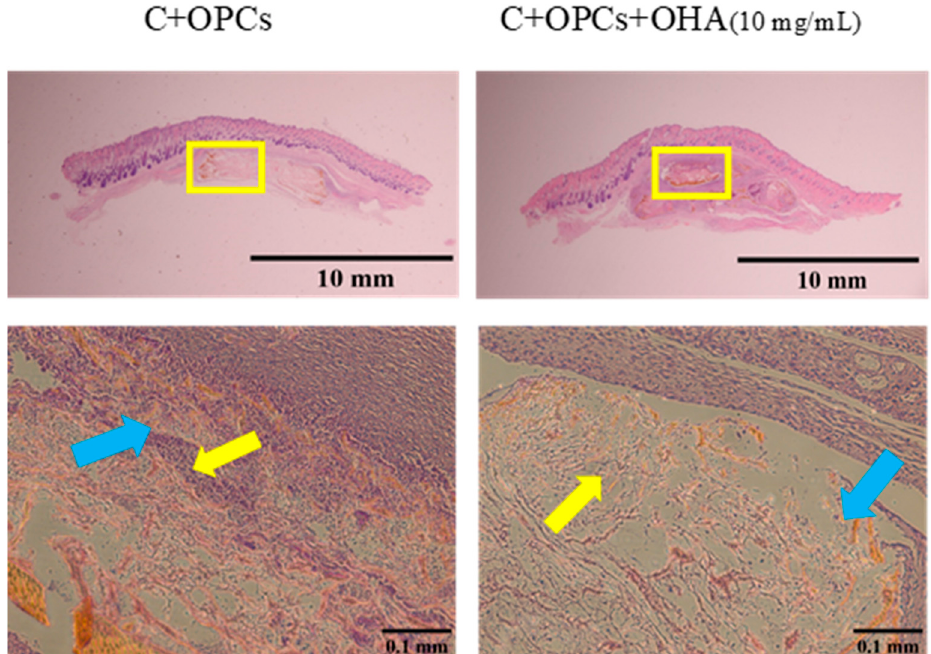
Figure 15. Histological images of control (Blank), collagen + OPC, and collagen + OPC + OHA scaffolds implanted on a skull defect captured after 4 weeks (upper panel). Enlarged images of areas within the yellow squares in the upper panels are shown in the lower panels (yellow arrows indicate the formation of new blood vessels, and blue arrows indicate the scaffolds).